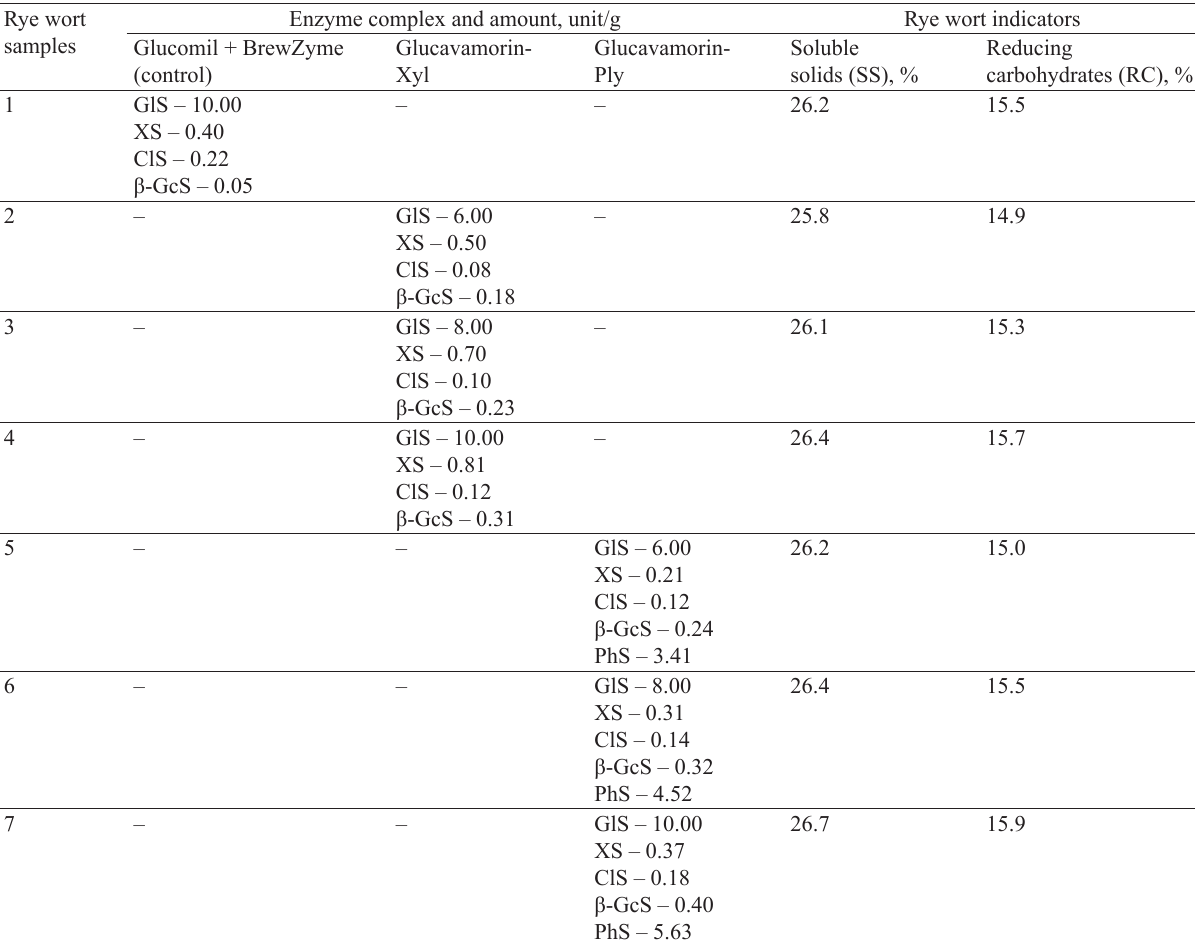
Table 3 Effects of enzyme complexes derived from recombinant strains on the concentration of rye wort and content of reducing carbohydrates Rye wort Enzyme complex and amount, unit/g Rye wort samples